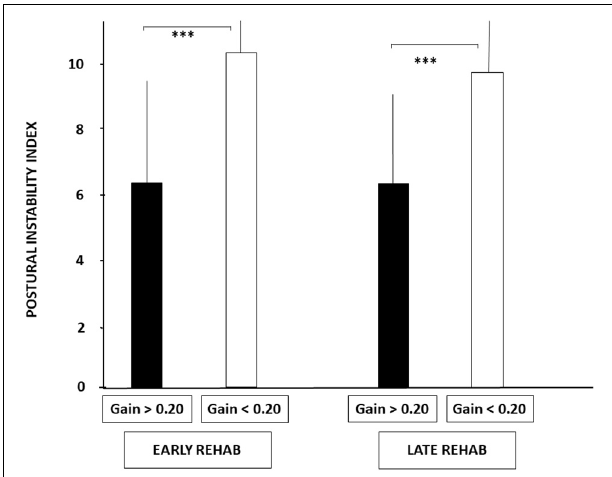
FIGURE 3 | Increased postural instability before vestibular rehabilitation in UVH patients with a higher degree of vestibular hypofunction. The degree of vestibular loss on the weaker side was attested by the aVOR gain (see section “Materials and Methods”). Postural instability index (PII) derived from the wavelet analysis is illustrated for the stabilograms recorded in dynamic posturography (unstable platform) with eyes closed. Histograms show the mean ( ± SD) PII scores recorded in the early and late rehabilitation sub-groups with aVOR gain either above 0.20 (filled histograms) or below 0.20 (open histograms). Significant differences depending on the degree of vestibular hypofunction are shown by asterisks. ∗∗∗ p <